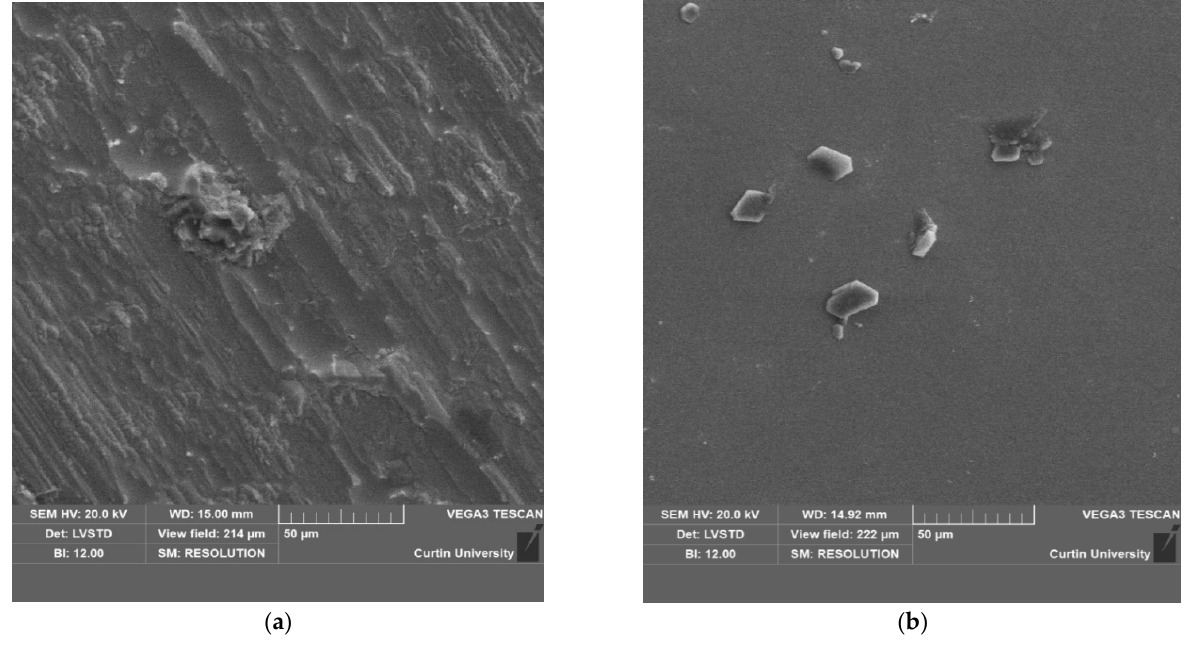
Figure 12. SEM images of surface of AMF fi bers in cement composites at ( a ) ambient temperature ( b ) 800 °C.